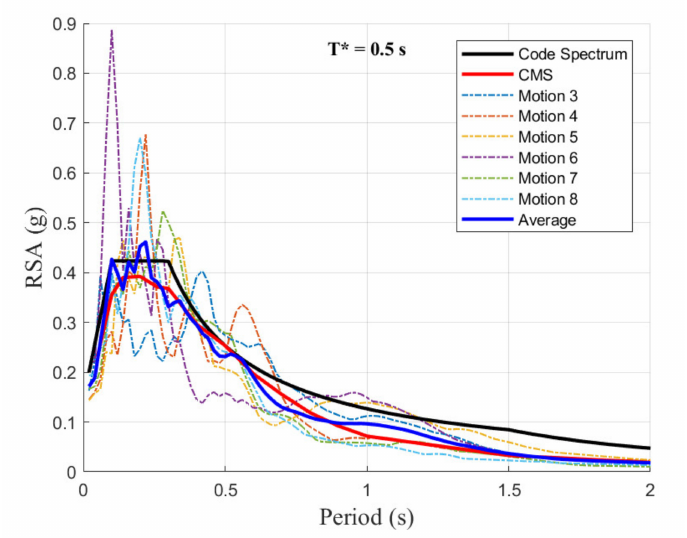
Figure 6. Case Study Output—bedrock ground motion ensemble, the CMS and the class B e code spectrum in response spectral acceleration format. Table 8. Case Study Output—detailed information about the bedrock ground motion ensemble. Ref.